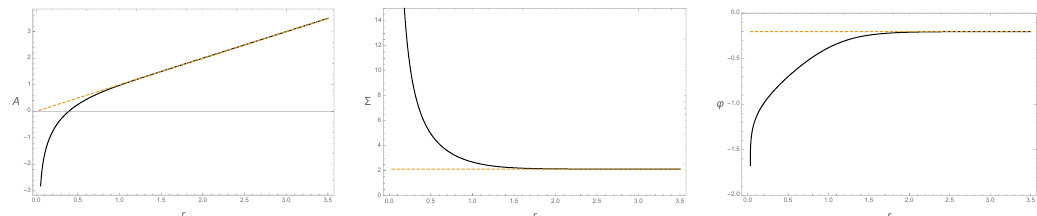
Figure 1 . UV scaling behaviour of various metric functions in the D = 7 uplift of the solution to the d = 5 BPS equations described in the text.